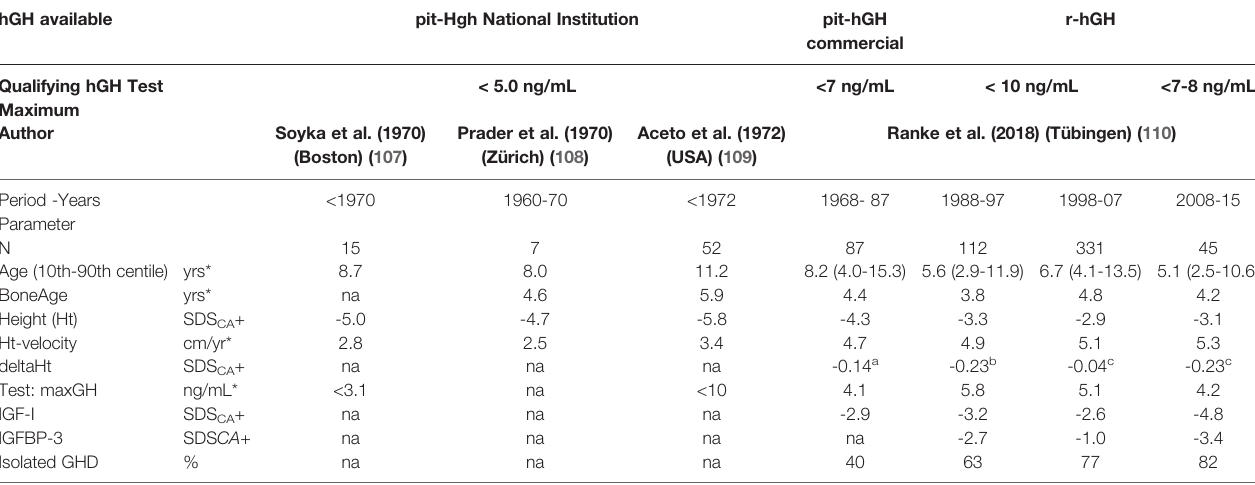
TABLE 2 | Characteristics of children and adolescents with non-acquired GHD (idiopathic GHD [IGHD] plus congenital GHD [cGHD]) at diagnosis). hGH